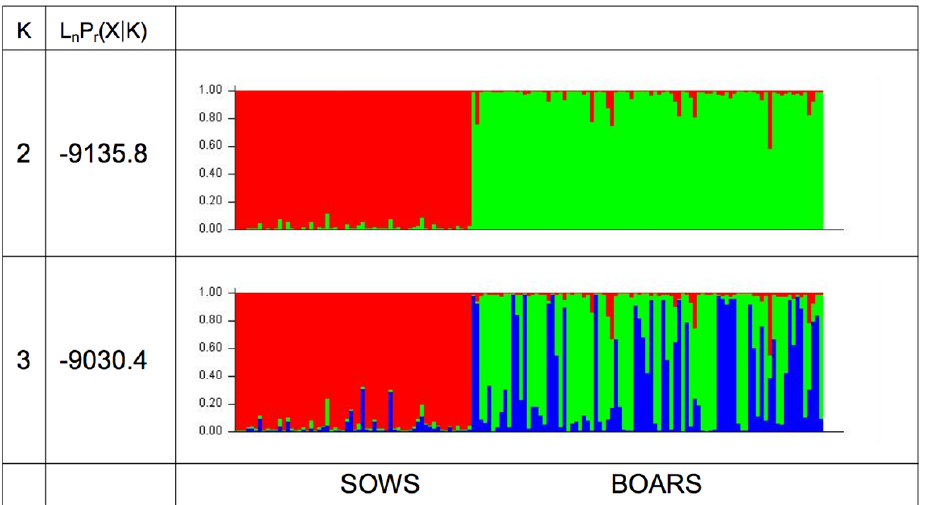
Figure 1. Graphical representation of the estimated membership fractions of individuals of the sows and boars analysed in each of the K inferred clusters, for K = 2 to K = 3.